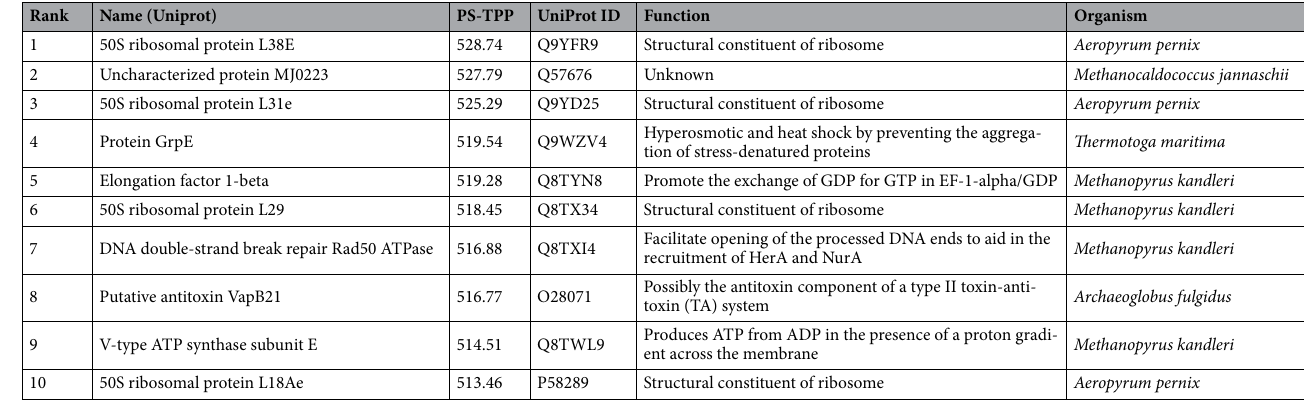
Table 6. Top ten TPPs having the highest PS-TPP derived from the proposed SCMTPP.